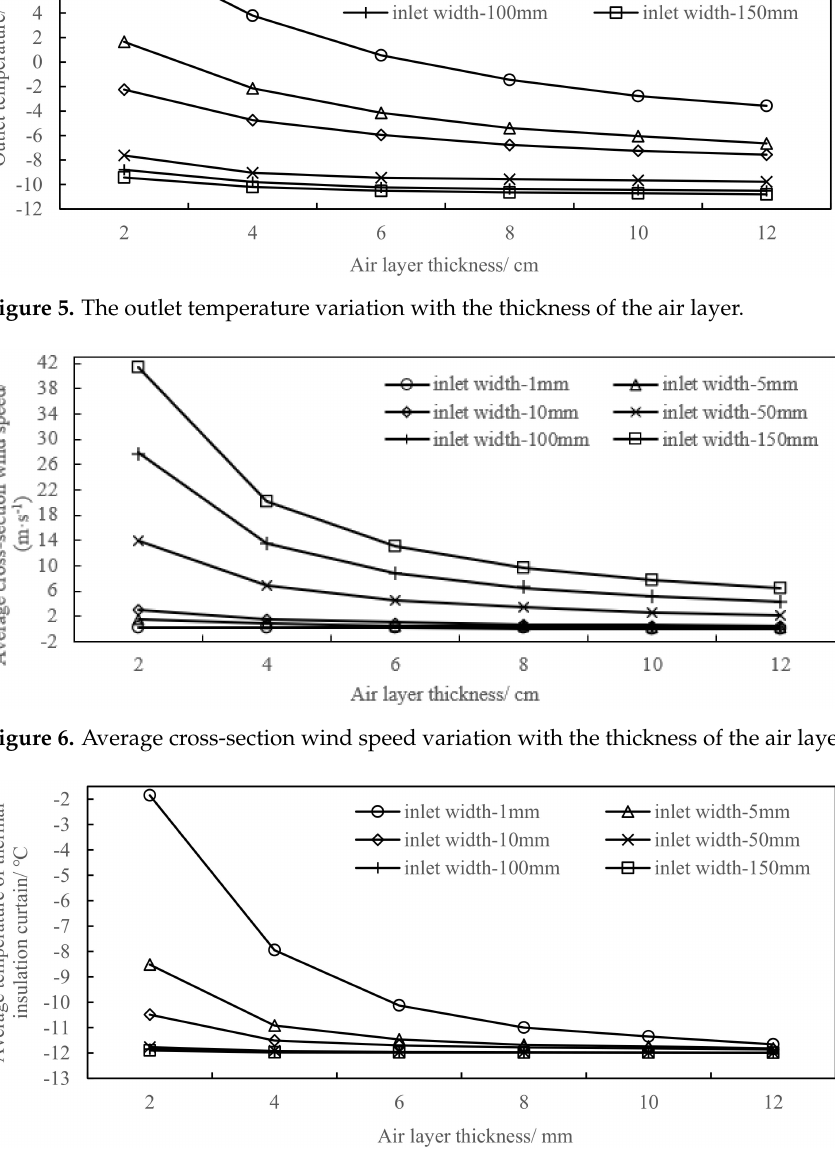
Figure 7. Thermal insulation curtain temperature changes with air layer